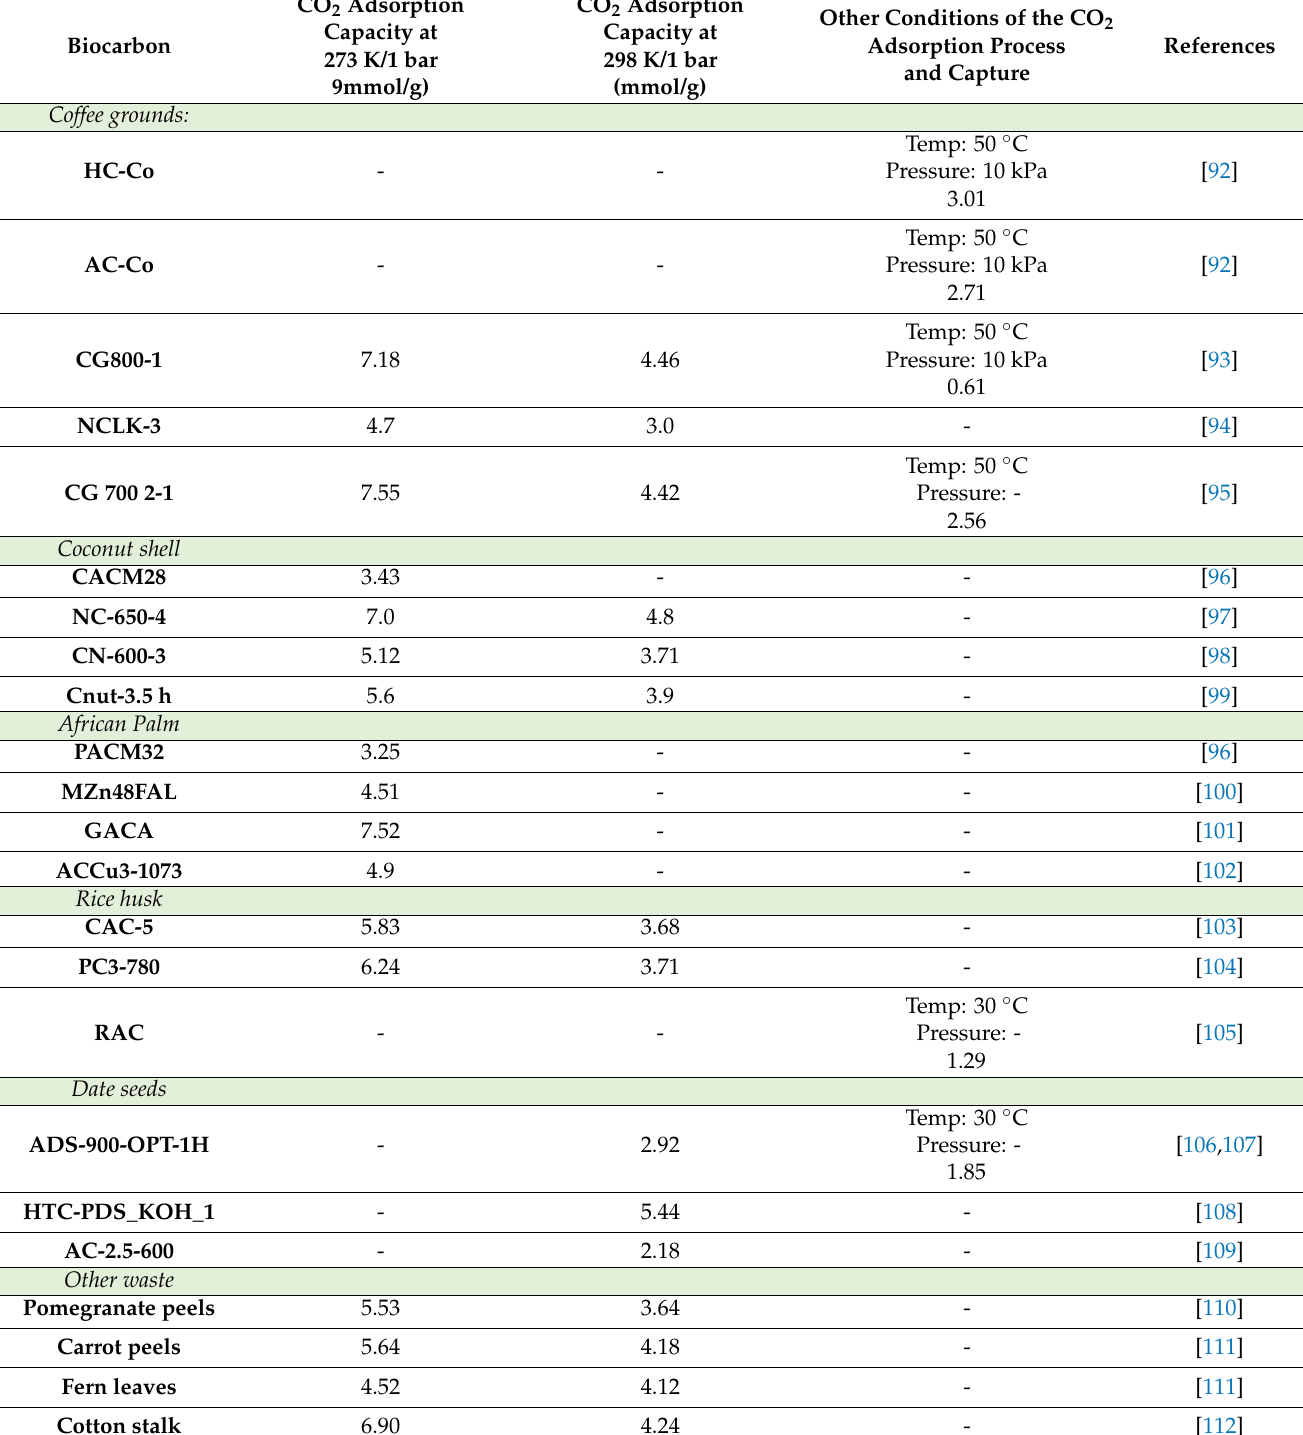
Table 4. Comparison of CO 2 adsorption capacity